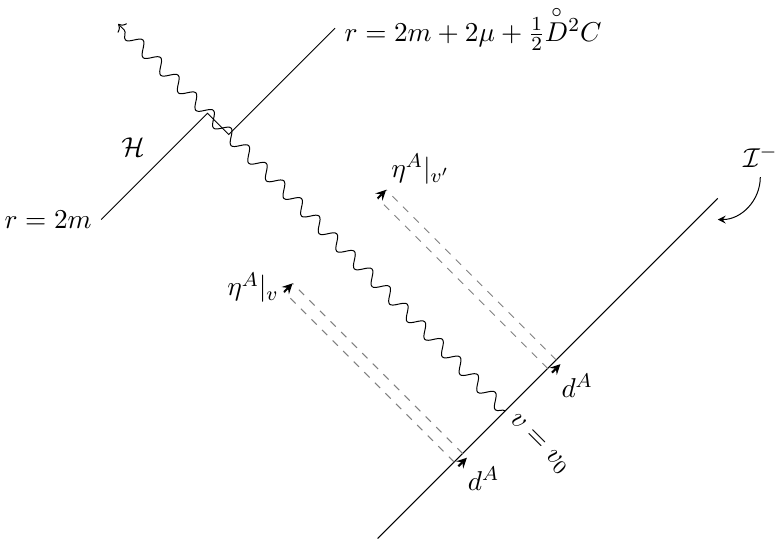
Figure 3 . A black hole subject to a shell of null matter entering the spacetime at v = v 0 . The geodesic deviation between a pair of light rays before v 0 and \the same" pair of light rays after v 0 may be compared as a way of detecting gravitational memory in the exterior of the black hole. Here \the same" is given a meaning by the conditions (i) and (ii) in the beginning of this